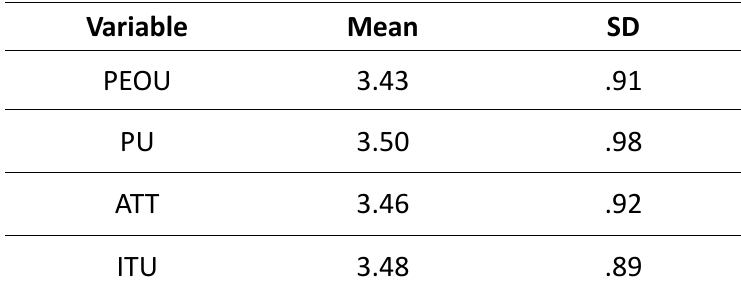
Mean and standard deviation of each variable